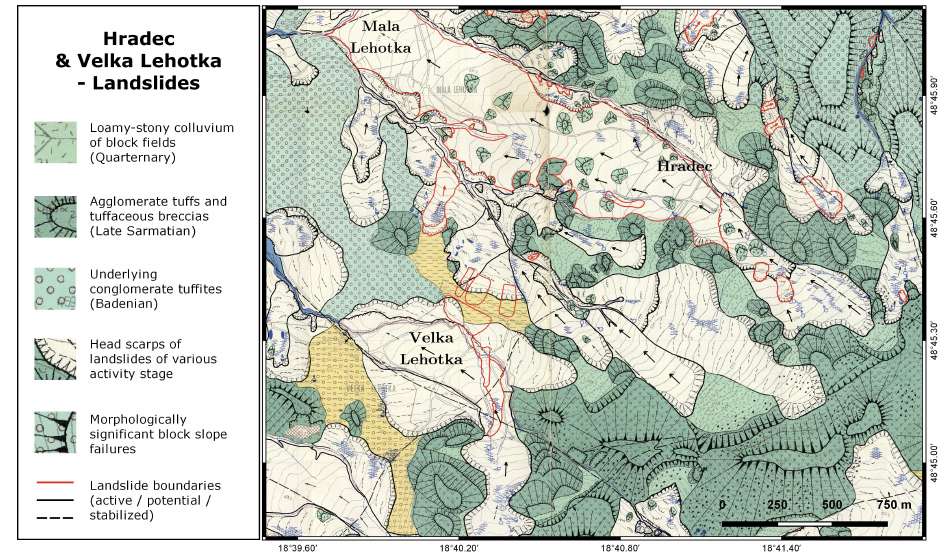
Figure 2. Case study 1: Slope deformations in Hradec, Velka a Mala Lehotka suburbs of Prievidza city, mapped by